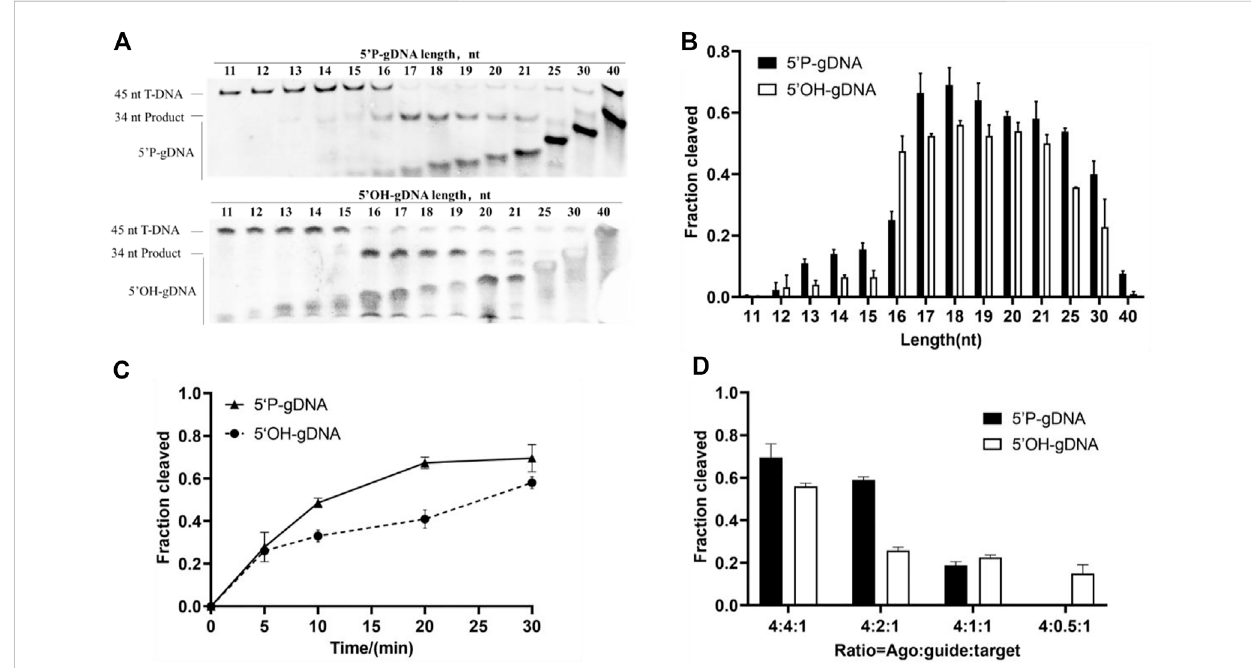
FIGURE 3 Effects of guide length and concentration on TtdAgo activity. (A) Effects of guide length on Ttd Ago activity mediated by 5 ′ -P-gDNA and 5 ′ -OH- gDNA. (B) Quanti fi cation ofcleavage ef fi cienciesfor (A) .The fraction ofthecleaved target for eachguide length isshown. (C) Cleavage kinetics ofssDNA using 5 ′ -P/5 ′ -OH DNA-guided Ttd Ago. (D) Effects of guide concentration on Ttd Ago activity mediated by 5 ′ -P-gDNA and 5 ′ -OH-gDNA. The assay in (A, B) was performed using 5 ′ -P-gDNA and 5 ′ -OH-gDNA of different lengths for 30 min. The assay in (C) was performed for indicated times (5, 10, 20, or 30 min) with 18-nt guides. The assay in (A, B, C) was performed with Ttd Ago, guide, and target at the molar ratio of 4:4:1 (800 nM Ttd Ago preloaded with 800 nM guide, plus 200 nM target). The assay in (D) was performed under different concentrations of guides for 30 min with 18-nt guides. All reactions were carried out in buffer containing 5 mM Mn 2+ at 75 °